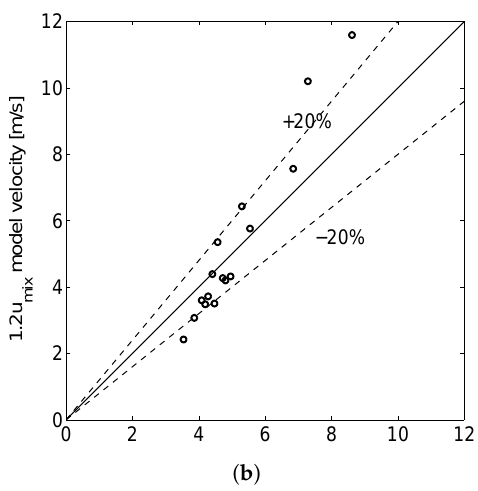
Figure 5. Slug mean velocity: numerical results are bounded by the ± 20% confidence lines. ( a ) Pipe1: numerical results against experimental data (left) and comparison with the relation by [47] (right); and ( b ) Pipe2: numerical results against empirical correlation.